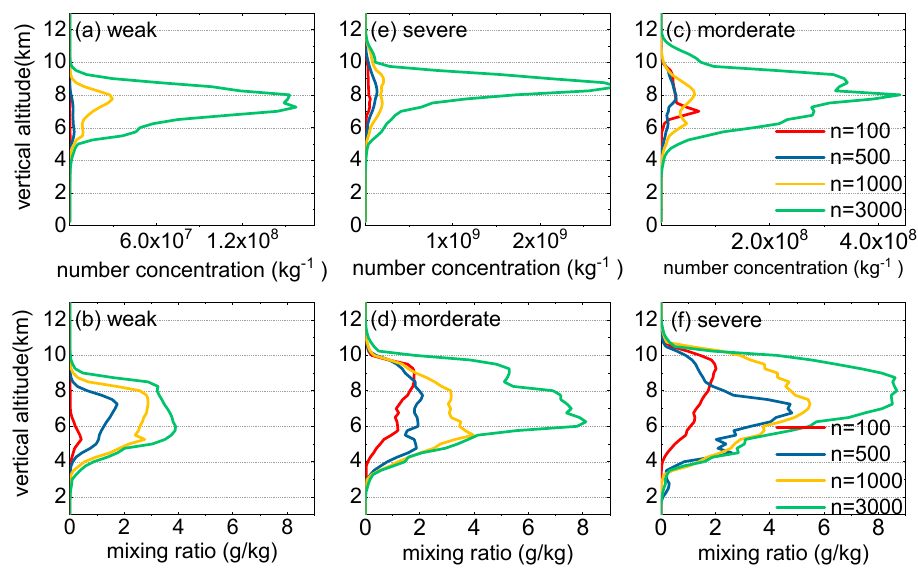
Figure 8. Vertical profiles of the maximum mixing ratio and the maximum number concentration of ice crystals in ( a ) weak thundercloud, ( b ) moderate thundercloud, ( c ) severe thundercloud; the maximum number concentration of ice crystals in ( d ) weak thundercloud, ( e ) moderate thundercloud, ( f ) severe thundercloud.